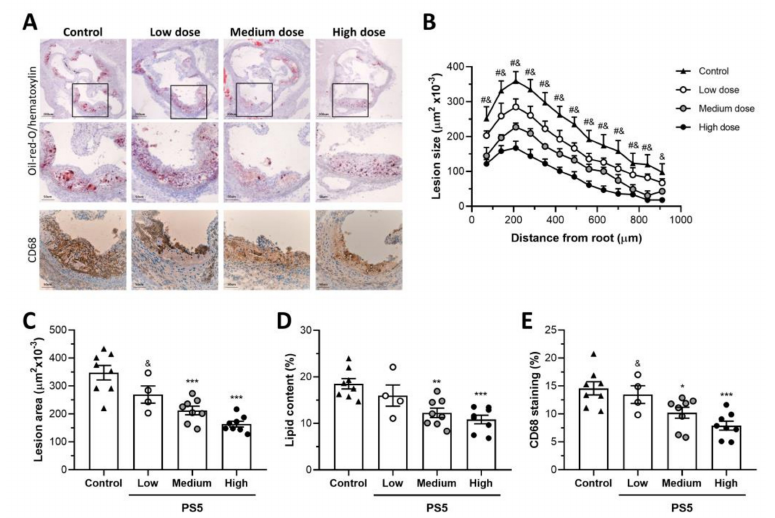
Figure 4. E ff ects of PS5 administration on atheroma plaques. ( A ) Representative images of Oil-red-O / hematoxylin staining and CD68 immunostaining (original magnifications, x40 and x100) in aortic sections of ApoE KO mice untreated (control, n = 8) and treated with low (19 µ g / mouse, n = 4), medium (38 µ g / mouse, n = 8) and high (79 µ g / mouse, n = 8) doses of PS5 peptide. ( B ) Quantification of the extent of atherosclerotic lesions within the aorta. ( C ) Average of individual maximal lesion area in each group. Quantitative analysis of ( D ) lipid content and ( E ) CD68 + macrophages in atheroma plaques (calculated as % positive staining per lesion area). Results are presented as individual data points and the mean ± SEM. * p < 0.05, ** p < 0.01 and *** p < 0.001 vs. control; # p < 0.05 vs. medium dose; and p < 0.05 vs. high